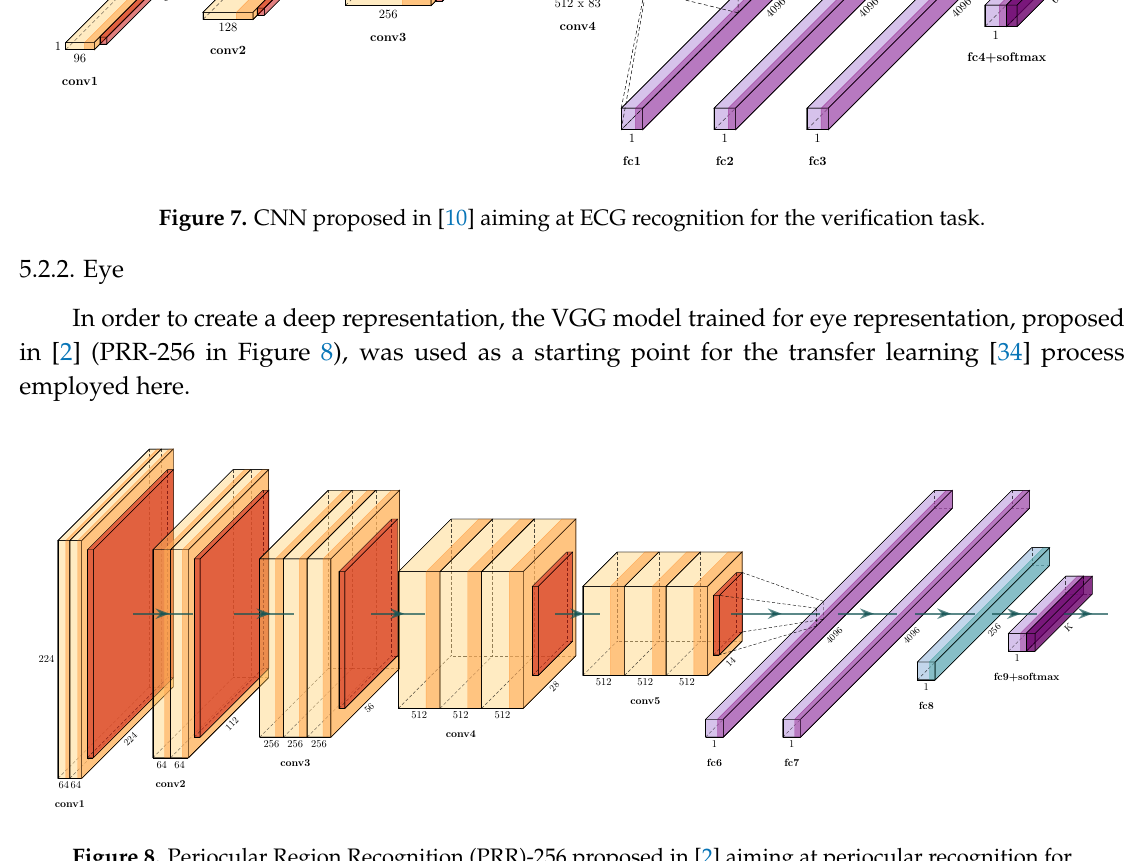
Figure 8. Periocular Region Recognition (PRR)-256 proposed in [2] aiming at periocular recognition for the verification